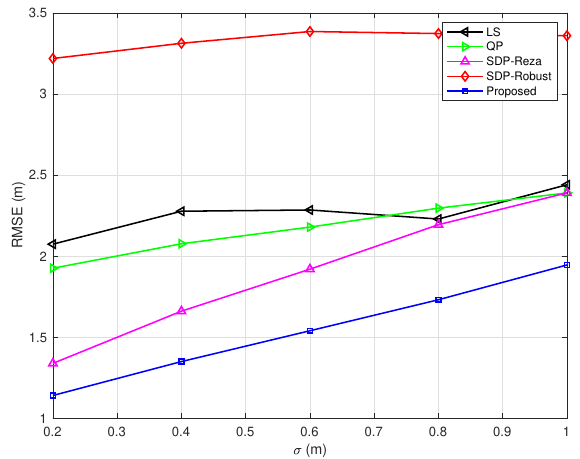
Figure 5. RMSEs vs. σ ( B max = 10 m and the number of NLOS links equals 4 ) .